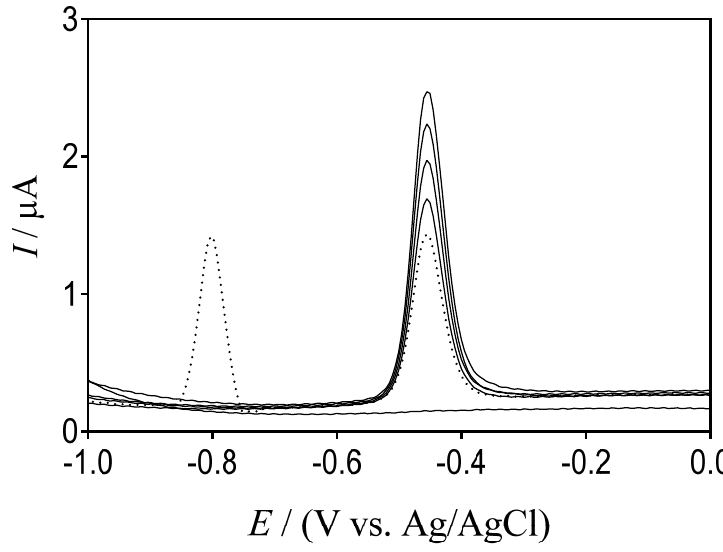
Figure 5. SWASV curves of GrRAC-70% recorded for different concentrations of Pb(II) in 0.5 M H 2 SO 4 in the presence of a fixed concentration of interfering metal ions (10 µmol/L).